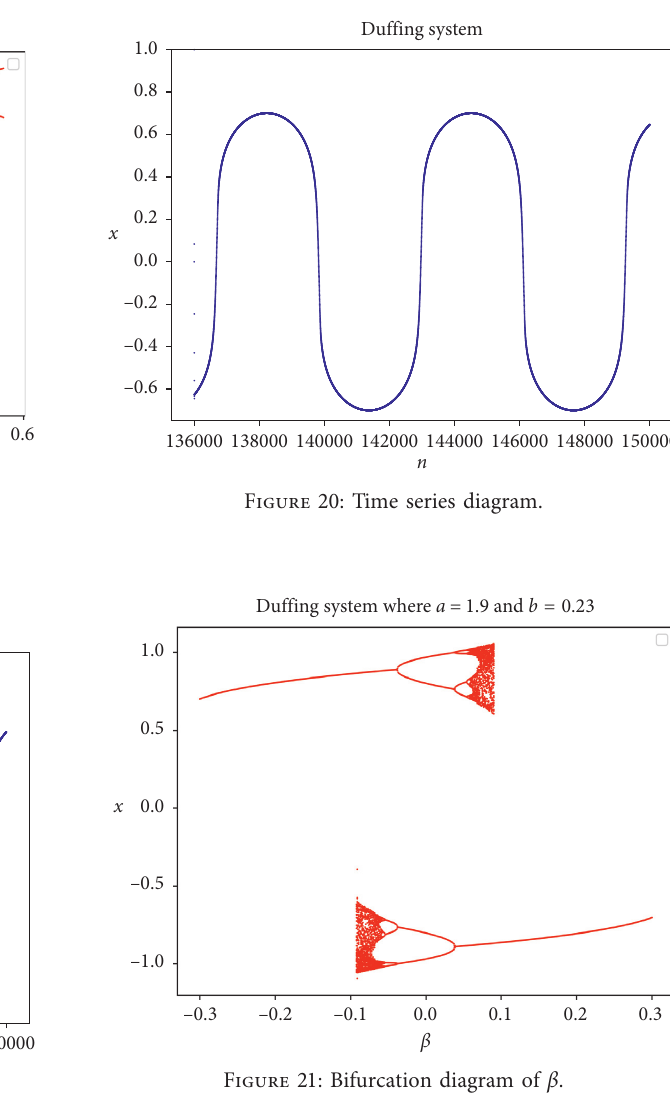
Figure 18: Time series diagram.